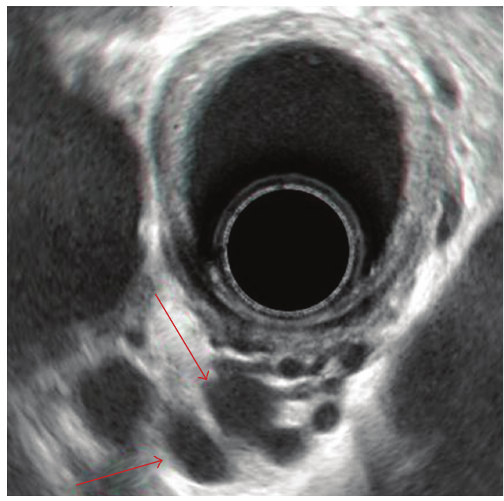
Figure 1: “Deep” oesophageal varices (red arrows) on endosono- graphic